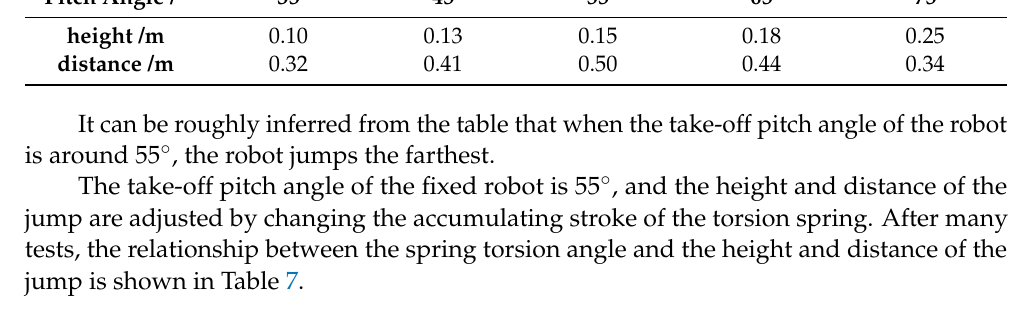
Table 7. Relationship between torsion angle of spring and jump height and distance.